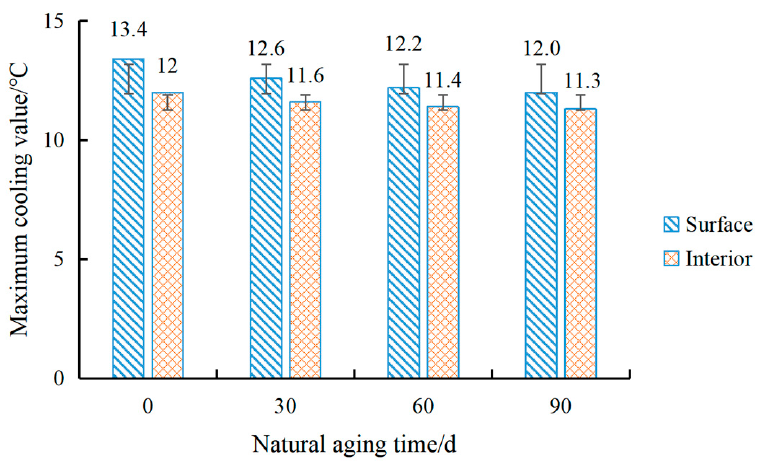
Figure 20. The cooling amplitude diagram of the coating after aging. decreases with the continuous natural aging process. After 90 days, the maximum cooling values on the surface and inside are weakened by 1.4 ◦ C and 0.7 ◦ C, respectively. The main